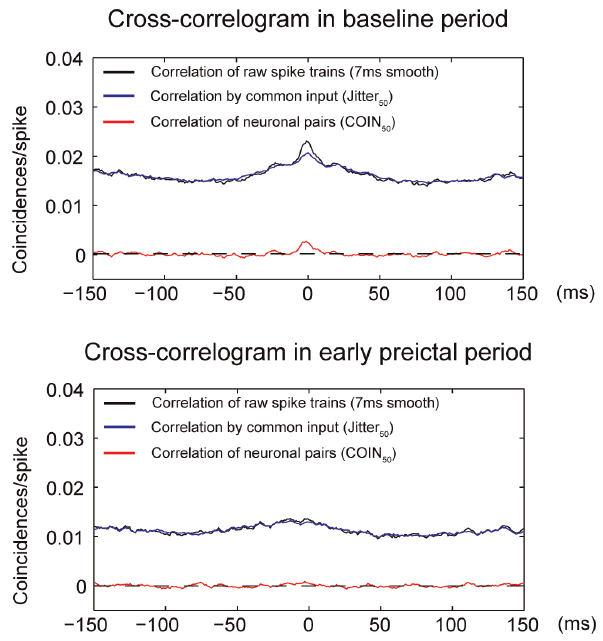
Figure 5. Cross-correlation histograms show coincident firing of a sample pair of neurons from one SE rat between the baseline period and early preictal period. Black line indicates the raw correlation smoothed with a 7 ms boxcar window (CCH raw ). The jitter-predicted correlation (Jitter 50 , blue) indicates the correlation driven by common input, as determined by jitter shuffling of the spike train with a 50 ms window. The cross-correlogram (‘CCG’, or COIN 50 , red) corresponds to pair-specific coincident activity, defined as the difference between raw coincidences and jitter coincidences.